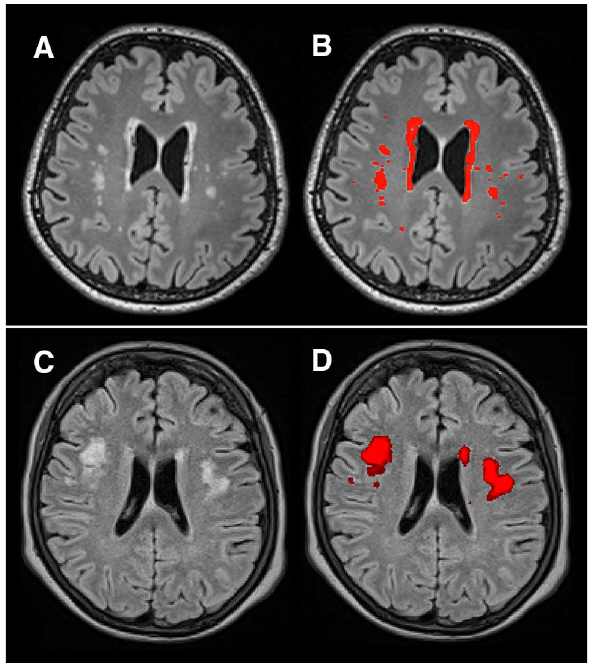
Figure 1. Example of manual WMH segmentation in the KORA sample ( A , B ) and automated WMH segmentation in the SHIP sample ( C , D ). ( A ) Axial view of the T2-weighted fluid attenuated inversion recovery data of a KORA participant with a WMH volume of 9600 mm 3 . ( B ) Manual segmentation of WMH in KORA. ( C ) Axial view of the T2-weighted fluid attenuated inversion recovery data of a SHIP participant with a WMH volume of 8600 mm 3 . ( D ) Automated multimodal segmentation of WMH in